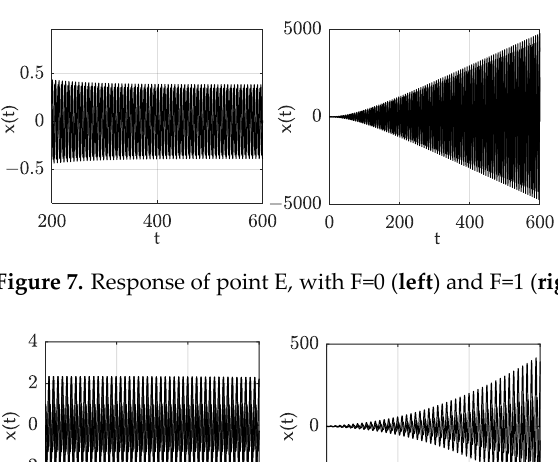
Figure 6. Response of point D, with F=0 ( left ) and F=1 ( right ). Figure 7. Response of point E, with F=0 ( left ) and F=1 ( right ).